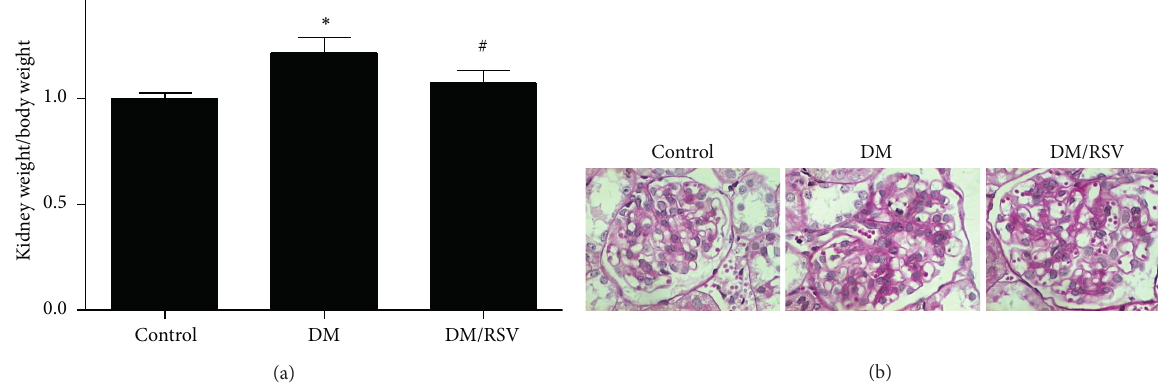
Figure 3: Resveratrol (RSV) protected mice from diabetes-induced renal hypertrophy and structural changes in mice. Kidney weight to body weight ratio (a) of three groups was presented. PAS staining of rat glomeruli sections ( ×400 ) was shown as Figure 3(b). Results represent as mean ± SD. ∗ 𝑃 < 0.05 compared with control group, # 𝑃 < 0.05 compared with diabetes mellitus (DM)